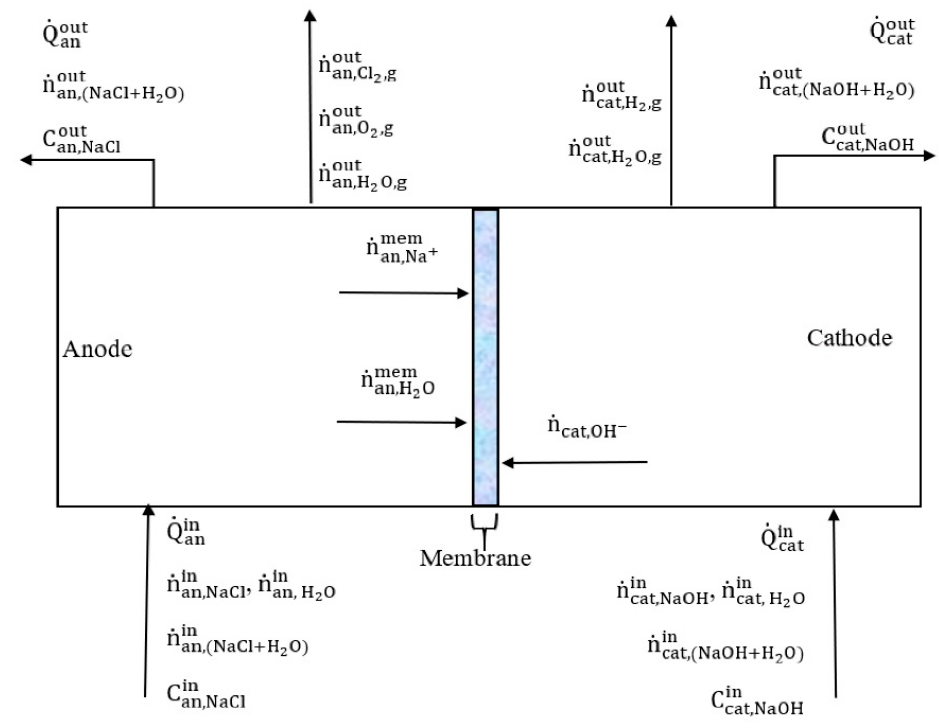
Figure 2. Illustration of molar and volumetric flow rates associated with the membrane chlor-alkali cell.